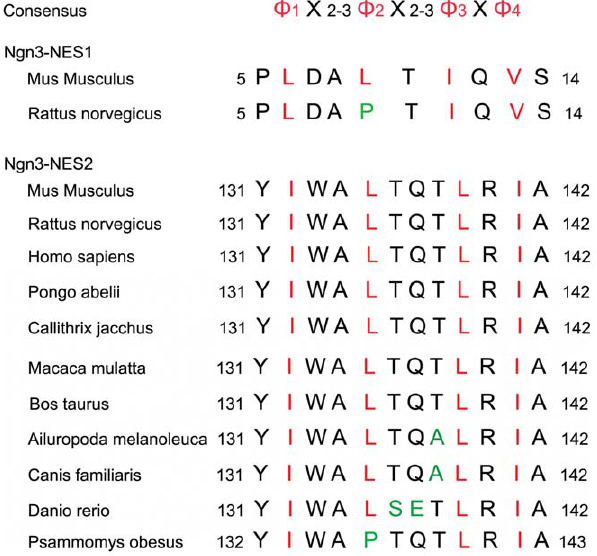
Figure 1. Comparison of putative nuclear export sequences (NESs) in Ngn3 protein with consensus NES motifs and Ngn3 homologues of various species. The putative NES2 sequence is well conserved in various species. In the consensus NES sequence, X indicates any amino acid and Ø indicates a hydrophobic residue, such as leucine, isoleucine, valine or methionine. Letters colored green correspond to amino acids that are not conserved in the species studied. Residues critical to NES activity are indicated by red letters.